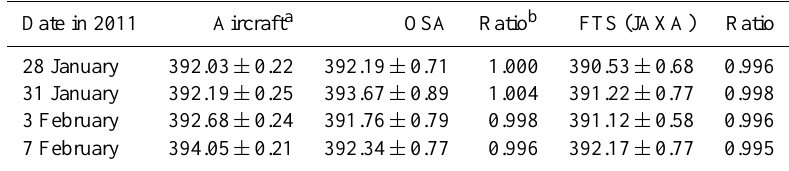
Table 3. Volume mixing ratios by aircraft, OSA and FTS at Tsukuba in Japan.